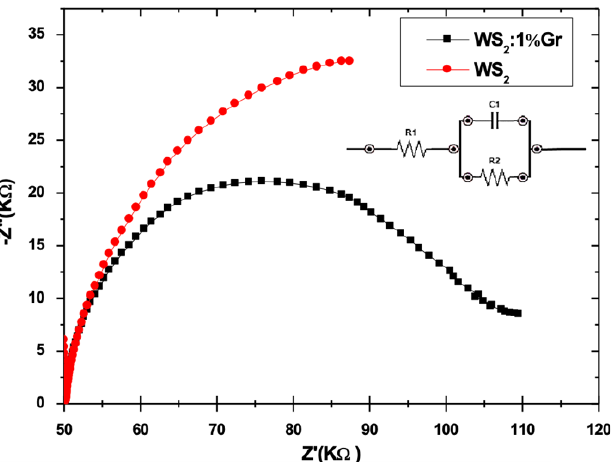
Figure 15. EIS measurements of WS 2 and WS 2 : 1 wt% Gr samples. The inset is the equivalent circuit used to extract the resistance of both samples.